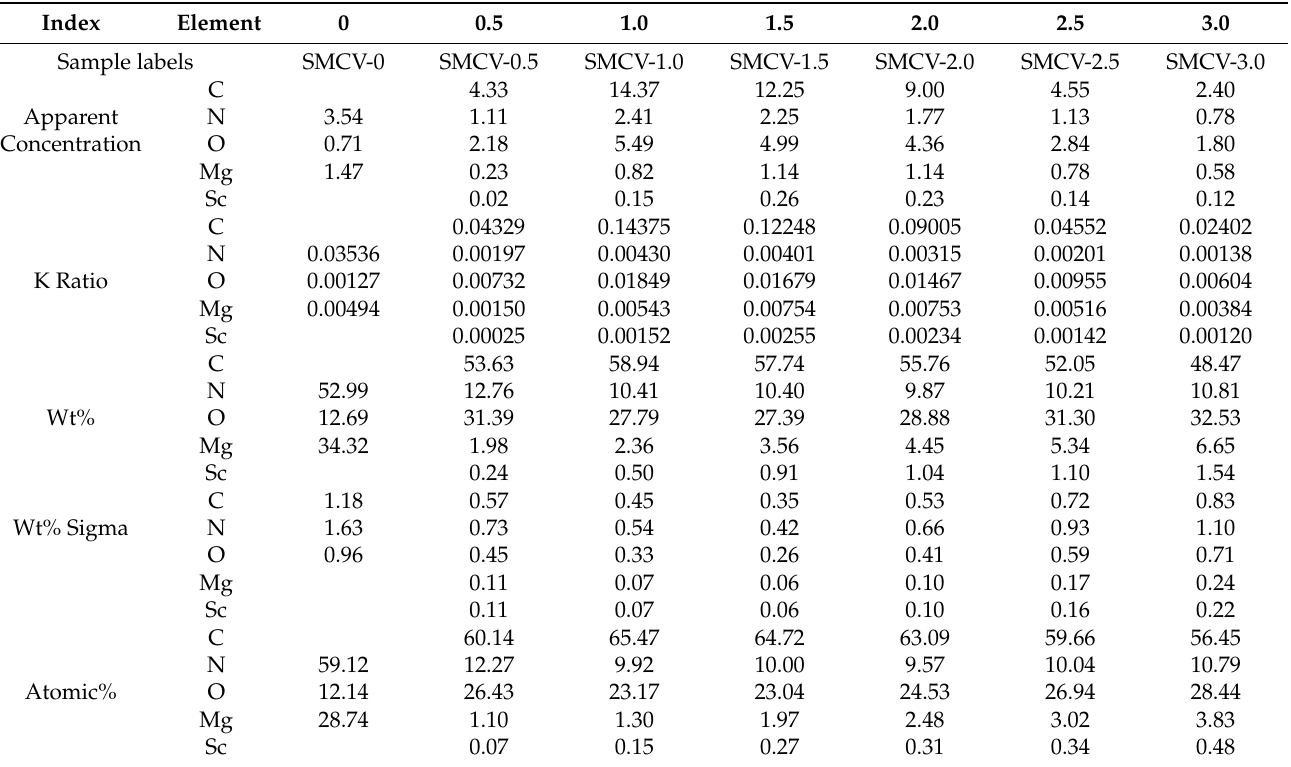
Table 1. The EDS data results of